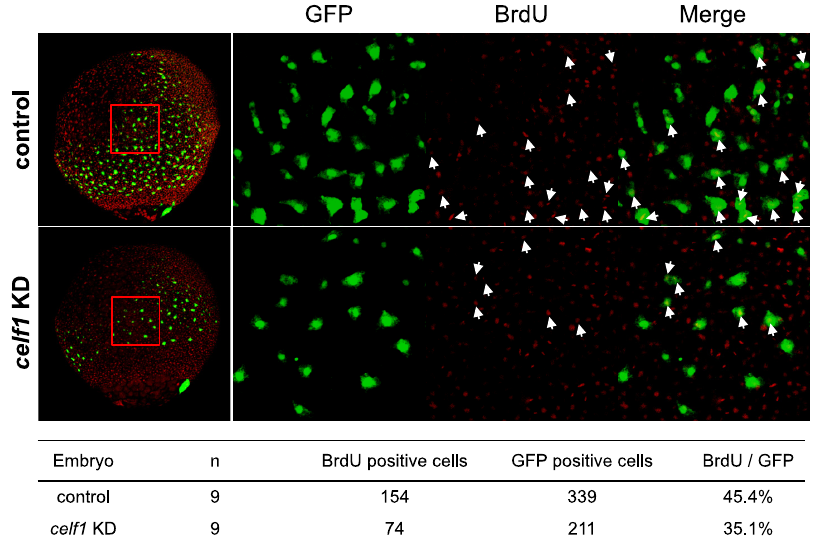
Figure A3. Cell proliferation in zebrafish embryos during gastrulation. BrdU staining was performed in Tg [ sox17:GFP ] embryos at 9 hpf. Green and red signals indicated GFP-expressing endoderm cells and BrdU positive cells, respectively. Right panels were higher magnification images highlighting endoderm cells with the embryo ( left panel ). The number of BrdU positive endoderm cells (arrows, double positive cells) significantly decreased in celf1 KD embryos ( * p <